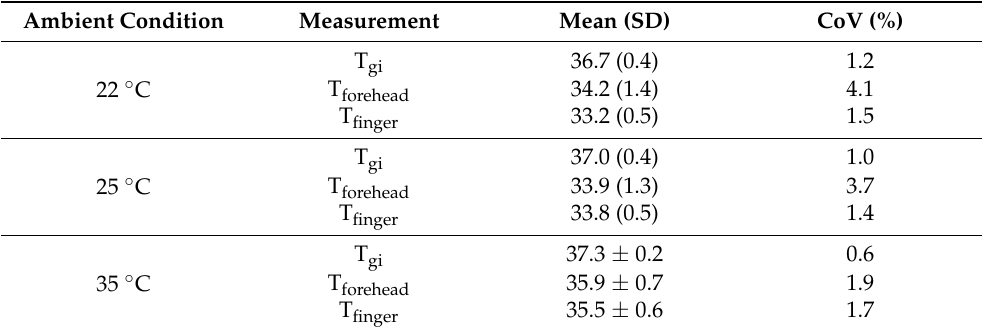
Table 2. Mean ( ± SD), and coefficient of variation (CoV) of Tsk and Tgi measurements at each ambient condition. Ambient Condition